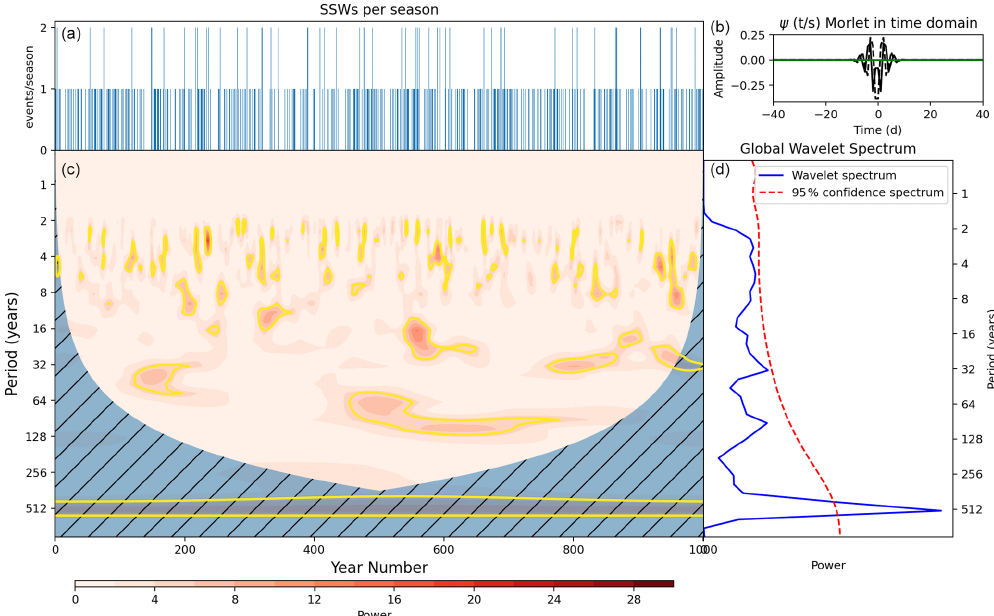
Figure 6. (a) SSW events per December–March season in UKESM. (c) Wavelet power spectrum of time series in panel (a) . Hatching represents area outside the cone of influence in which edge effects are significant and power should not be considered. Yellow contours represent the 95% confidence level assuming mean background AR1 red noise. (b) Morlet wavelet used for the wavelet transform in the time domain. (d) Global power spectrum, the wavelet power averaged over the whole simulation (blue line) and global 95% confidence spectrum (dashed red